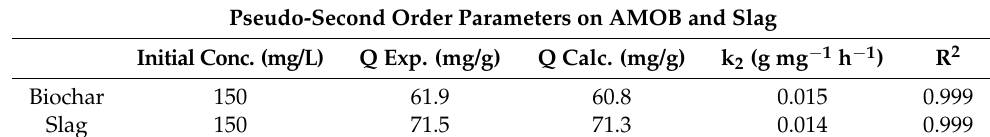
Table 2. Pseudo-second order parameters for phosphate adsorption [pH = 5.0; adsorbent dose = 1.0 g/L; 150 mg/L PO 43 − ; 25 ◦ C; 150 rpm shaking] .